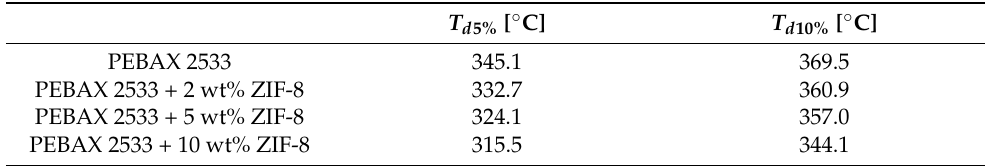
Table A1. Temperatures at which the weight of the sample decreases by 5 wt% and 10 wt% for a membrane containing different concentrations of ZIF-8.